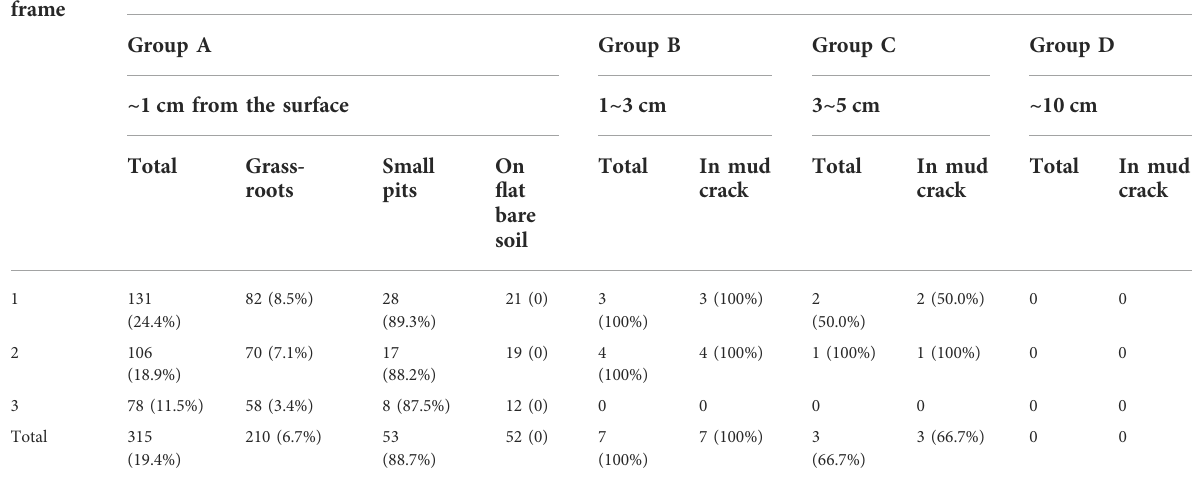
TABLE 3 The B. globosus parameters in fi eld desiccation experiment. Observe